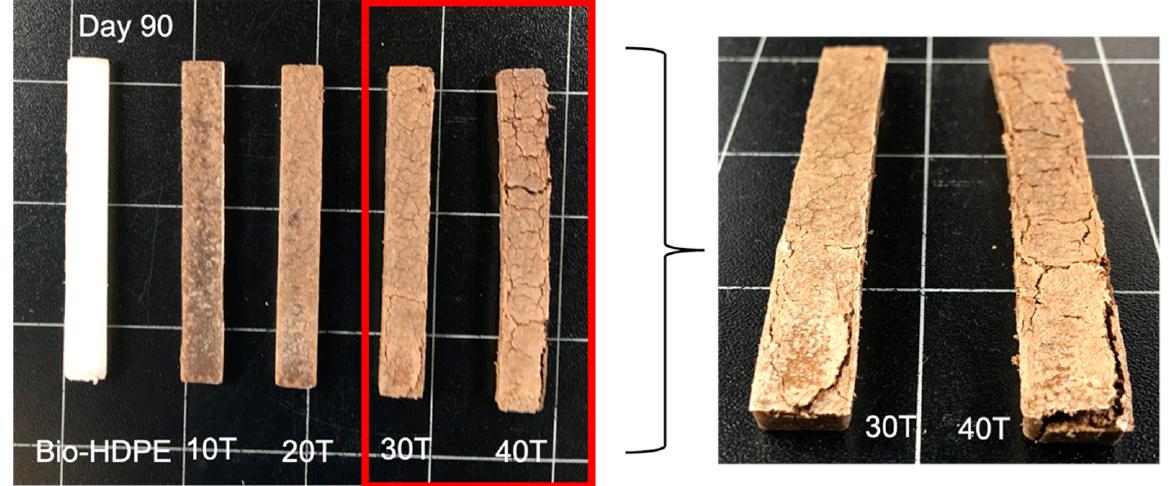
Figure 14. Visual appearance of disintegration of bio-based high-density polyethylene (Bio-HDPE) with different weight percentage of treated chia seed flour with APS under compost conditions.